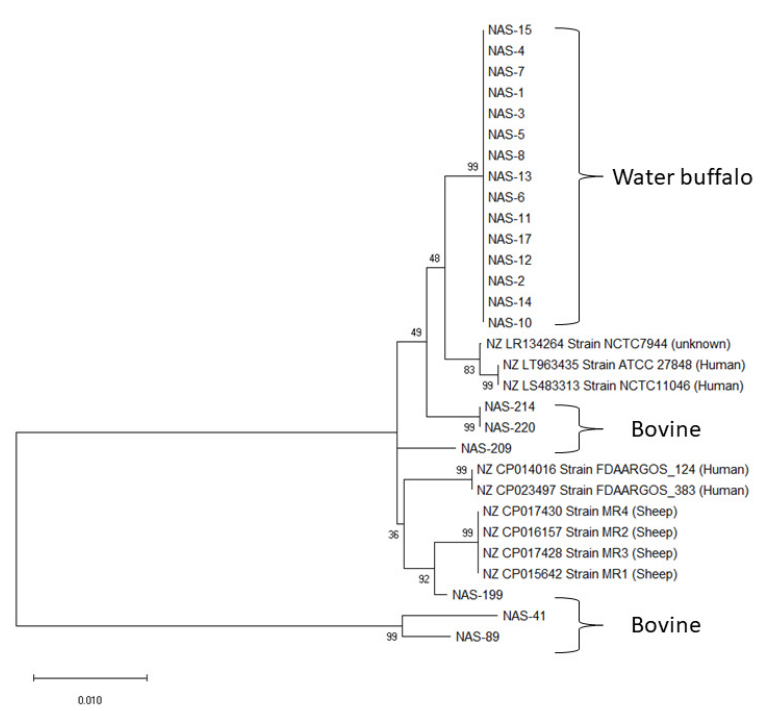
Figure 1. Phylogenetic demonstration of the relationship of 21 S. simulans isolates compared to 9 random whole S. simulans genomes published in NCBI. The dendrogram was constructed by using the combined nucleotide sequences of the seven housekeeping genes ( PyrR , glPk , Gmk , AdhP, Xpt, PTA , InfB) with the maximum likelihood